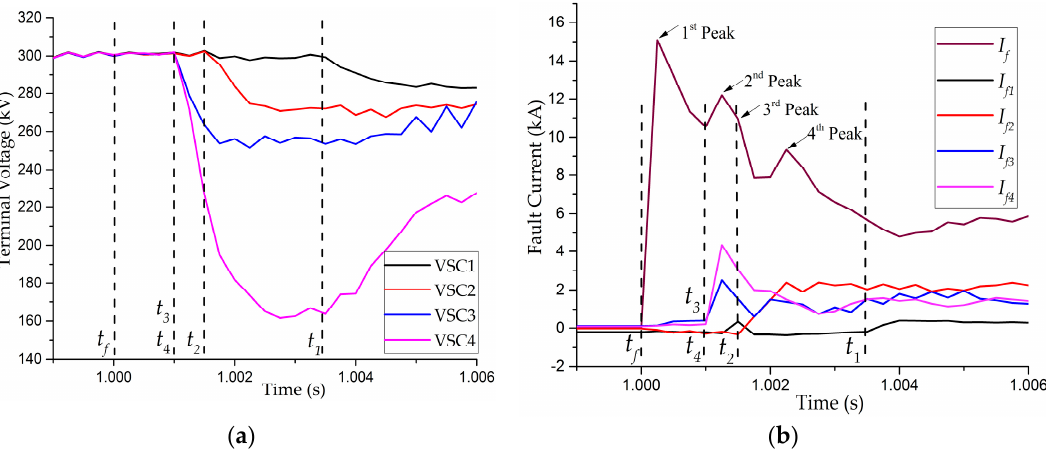
Figure 7. Propagation time delay in MTDC (multi-terminal high voltage direct current) network. ( a ) Voltage response, ( b ) current response.